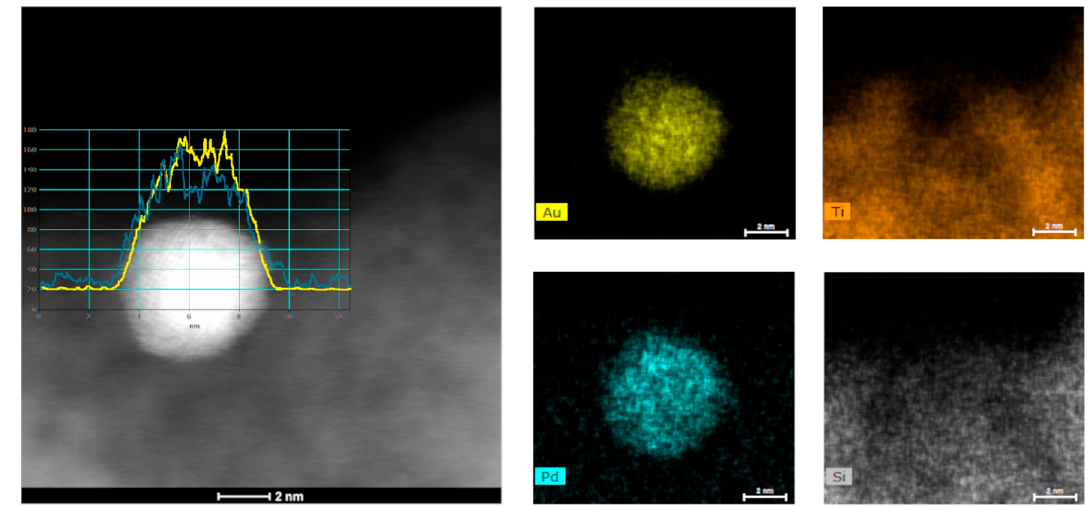
Figure 3. HRTEM HAADF image of the Au 1 Pd 1 @SiTi catalyst and X-ray mapping of the sample.